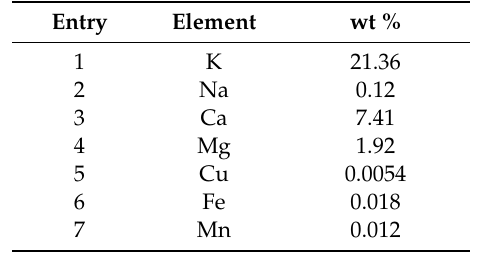
Table 1. ICP-AES analysis of the pomelo peel ash.